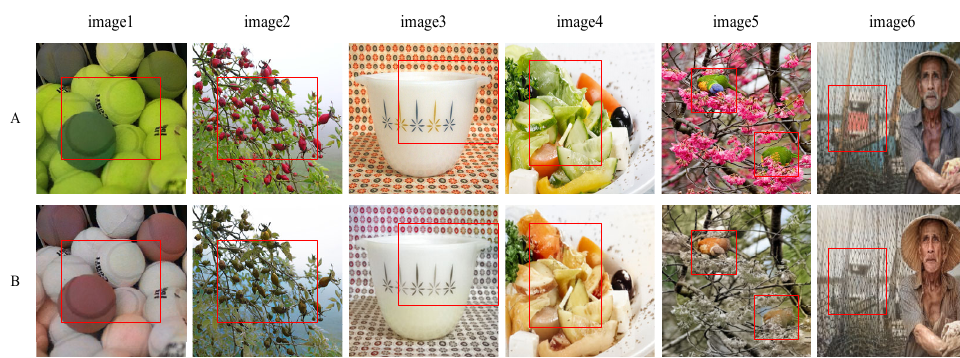
Figure 11. Failure cases. ( A ) Real image; ( B ) Proposed method. The red rectangular box represents